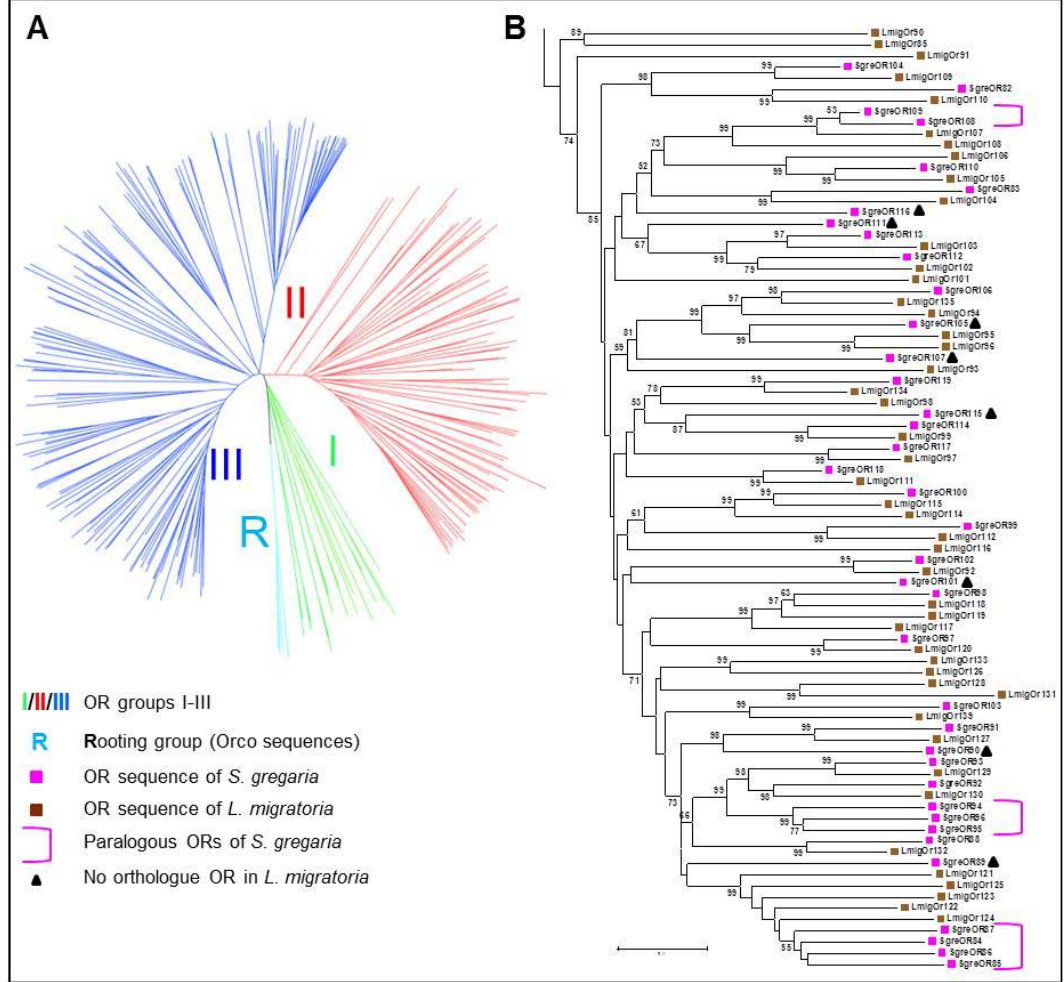
Figure 1. Phylogeny of S. gregaria (SgreORs). ( A ) Phylogenetic tree comprising ORs from S. gregaria (SgreOR) and L. migratoria (LmigOr). The tree was modified from [32] and is based on the original phylogenetic tree described in [24]. For simplification, a schematic representation of the phylogenetic tree is shown. The SgreORs were classified in three groups (I–III) indicated by the color code (I = green, II = red, III = blue). The outgroup used for rooting (Orco sequences, in light blue) is designated by “R”. ( B ) Rectangular representation of the branch of the phylogenetic tree harboring group II SgreORs and the corresponding LmigOrs. The scale bar indicates 10% di ff erence. The numbers in the tree specify bootstrap support values based on 1000 replicates (only values above 50% are given). SgreORs and LmigOrs are indicated by pink or brown squares, respectively. Pink brackets denote paralogous SgreOR clusters or pairs. Black triangles indicate SgreOR types without an orthologous sequence in L. migratoria